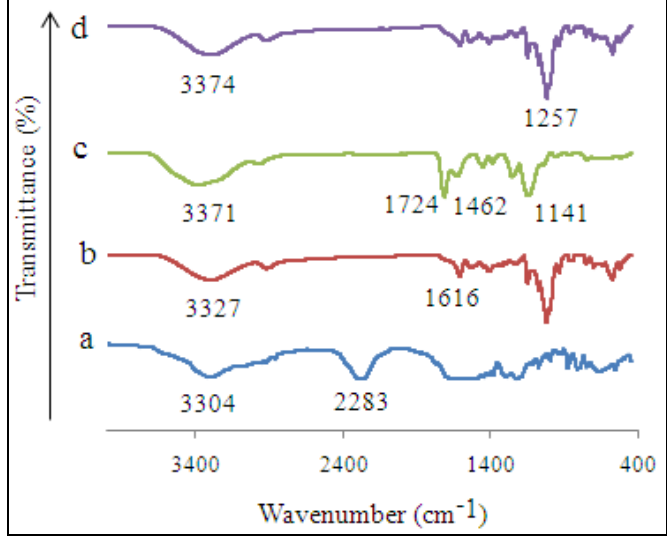
Figure 1. IR spectra of (a) MAA-TDI; (b) MAA-βCD; (c) MIP MAA-βCD; and (d) NIP